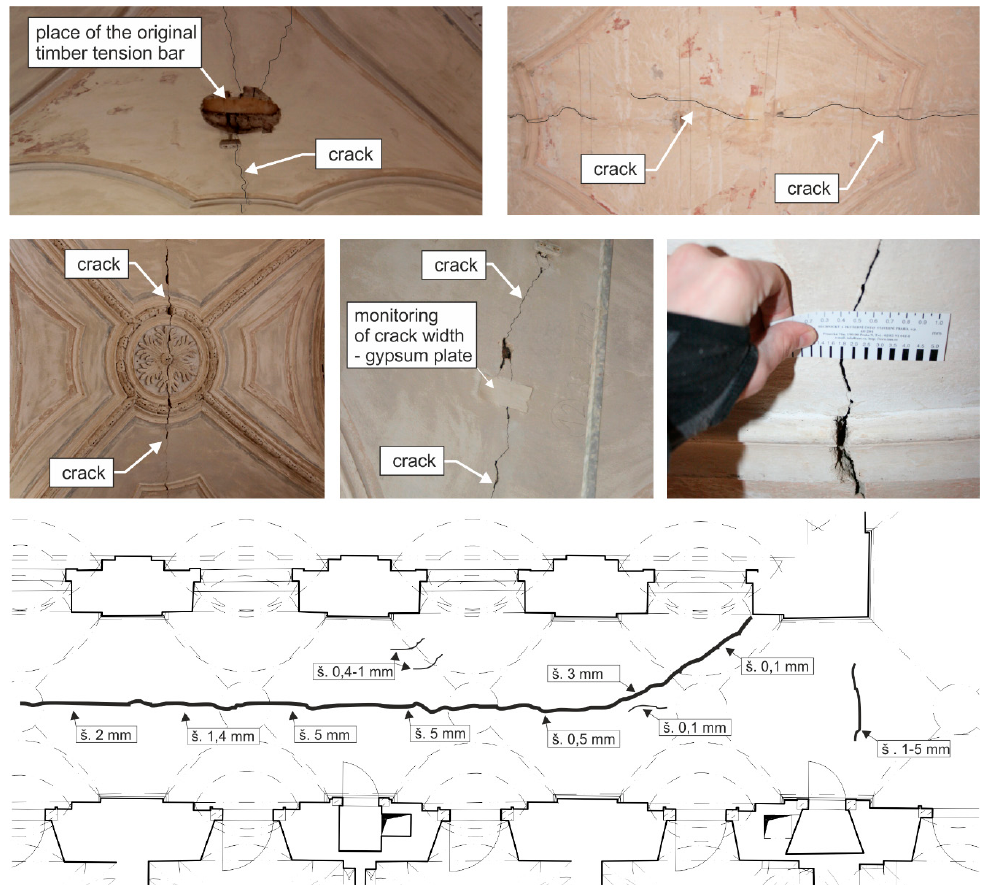
Figure 3. Damaged vaults over the convent’s east wing arcaded walk on 1st OS and the crack width measurements in the southeast corner of the convent.